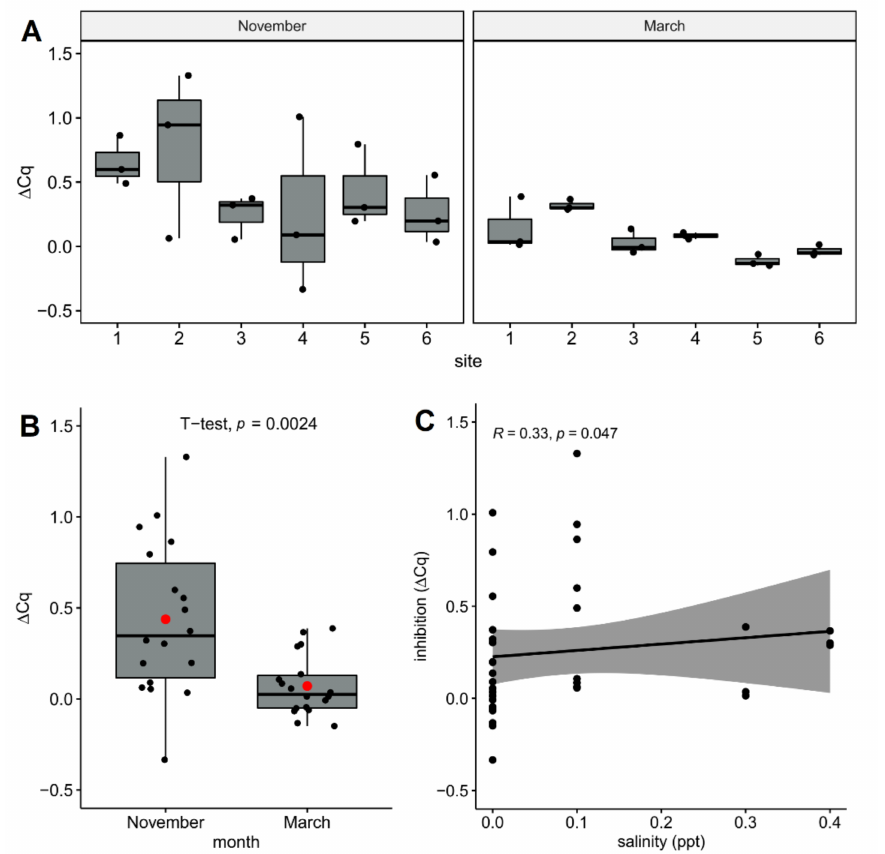
Figure 3. ∆ Cq value in the inhibition test of environmental DNA (eDNA) samples from the Yangyang- namdae River. ( A ) PCR inhibition across sampling sites and seasons; ( B ) mean and median values of delayed ∆ Cq value; and ( C ) Spearman correlation between ∆ Cq and salinity. Means and medians are presented as red circles and solid lines, respectively. Each data point is presented as a black